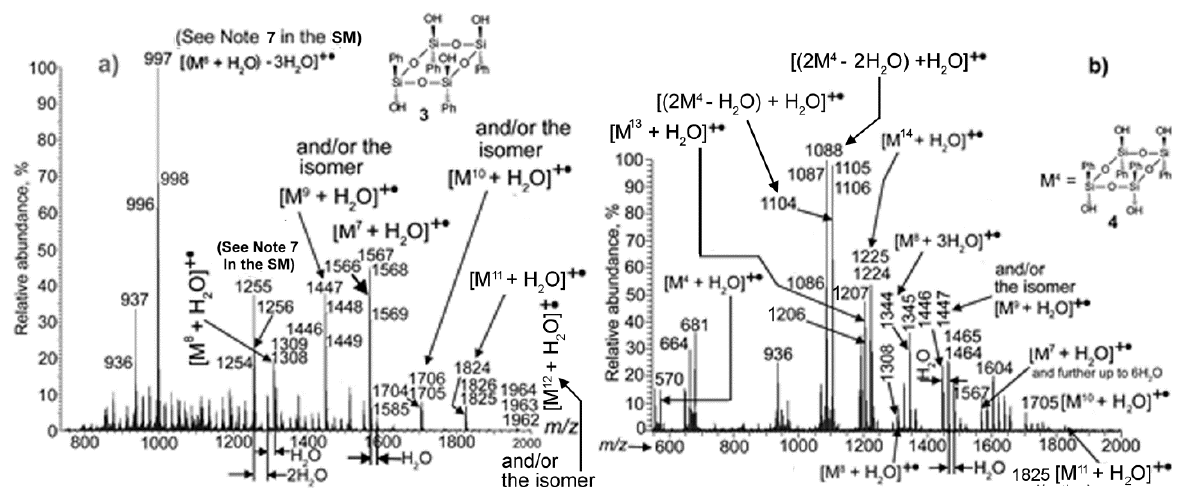
Figure 8. PI APCI mass spectra of precipitates from the reaction mixtures of condensation: ( a ) of compound 3 conducted in a quartz flask in toluene at 110 °C for 120 min and ( b ) of species 4 carried out in a quartz flask in anisole at 150 °C for 120 min (See Note 8 in the SI).